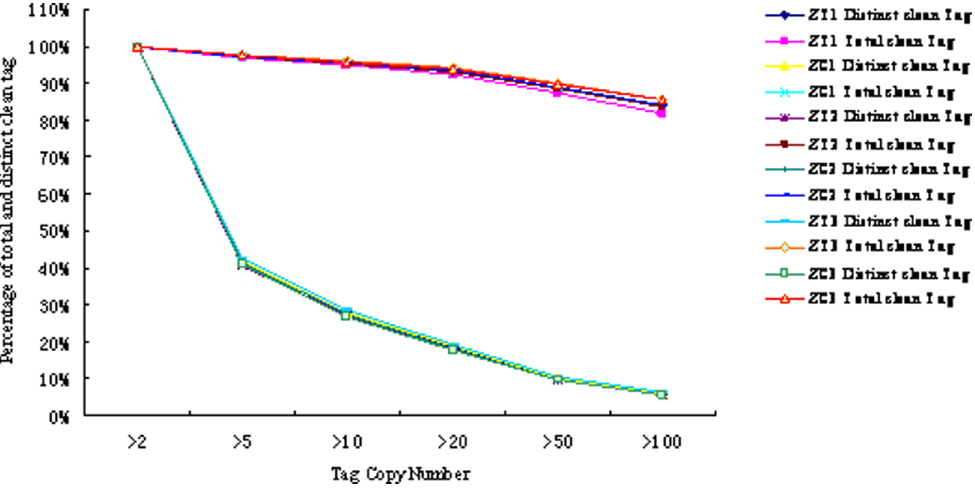
Figure 1. Abundance and categories distribution of the total and distinct clean tags of each library.